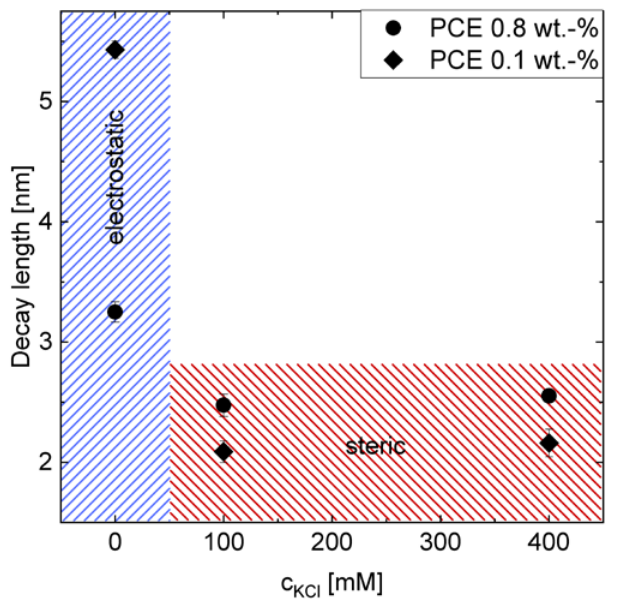
Figure 11. Decay length of approach curves for 0.1 % and 0.8 % PCE containing 0, 100, 400 mM KCl. No KCl implies electrostatic interaction, whereas for 100 mM and 400 mM, the Debye length is smaller than 1nm, implying steric interaction between the adsorbed PCEs side chains at the surfaces during approaching.